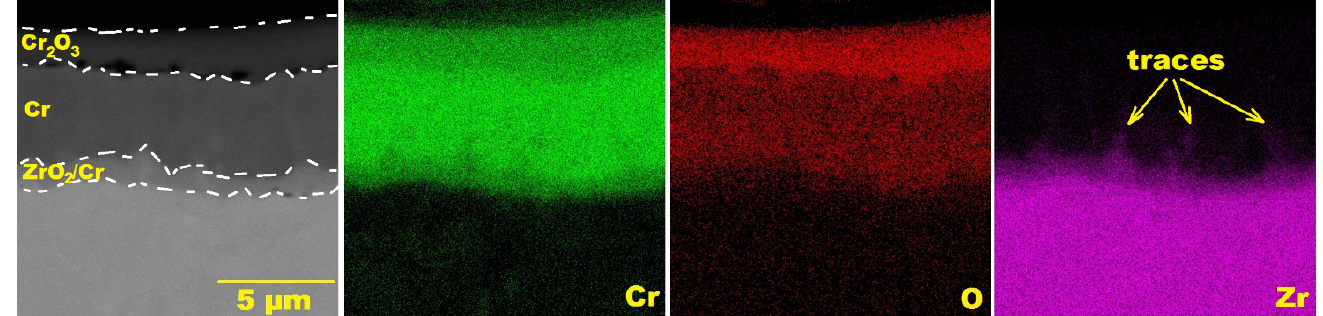
Figure 9. Cross-section SEM image of the ZrO 2 /Cr-100 sample after oxidation in water steam at 1200 °C for 1000 s and the corresponding EDS maps of Cr, Zr, and O.